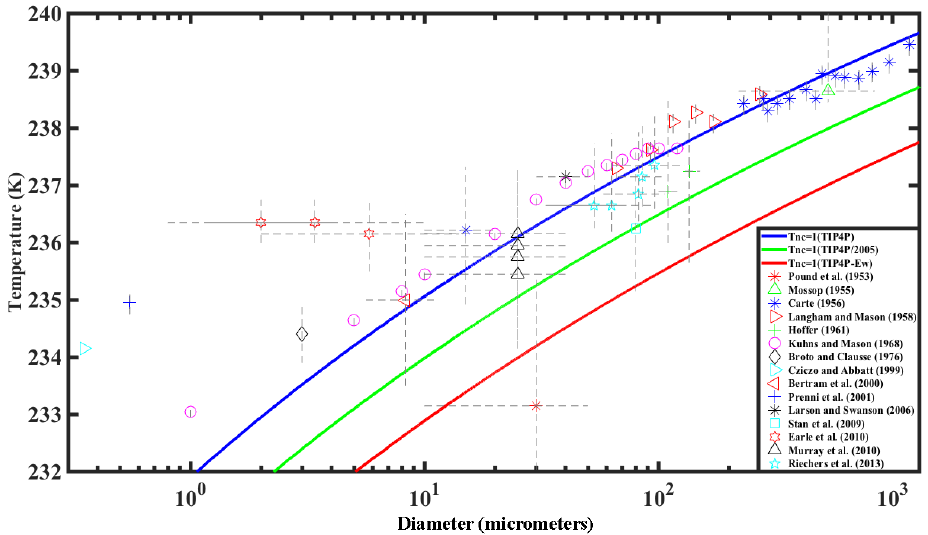
(V,a w = 1 ) and the collected ex- c = 1 (V,a w = 1 ) : blue line – σ i / w , e from the TIP4P c = 1